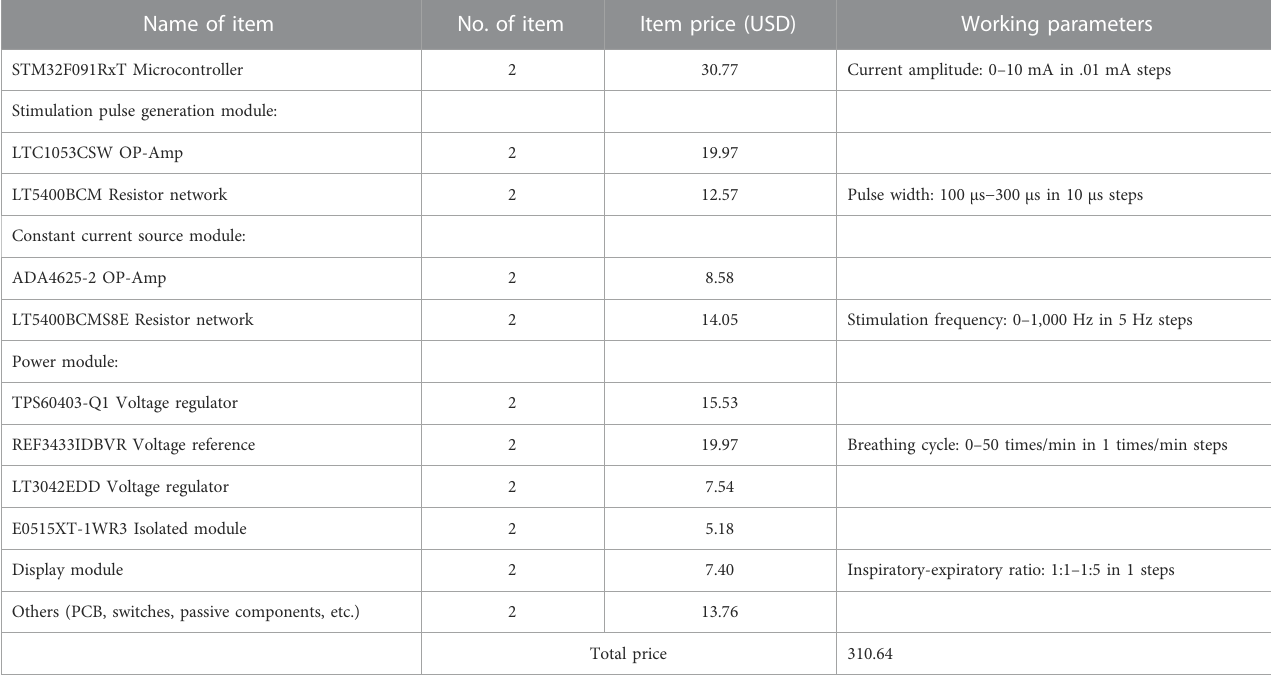
TABLE 2 Development details of DP system and its working